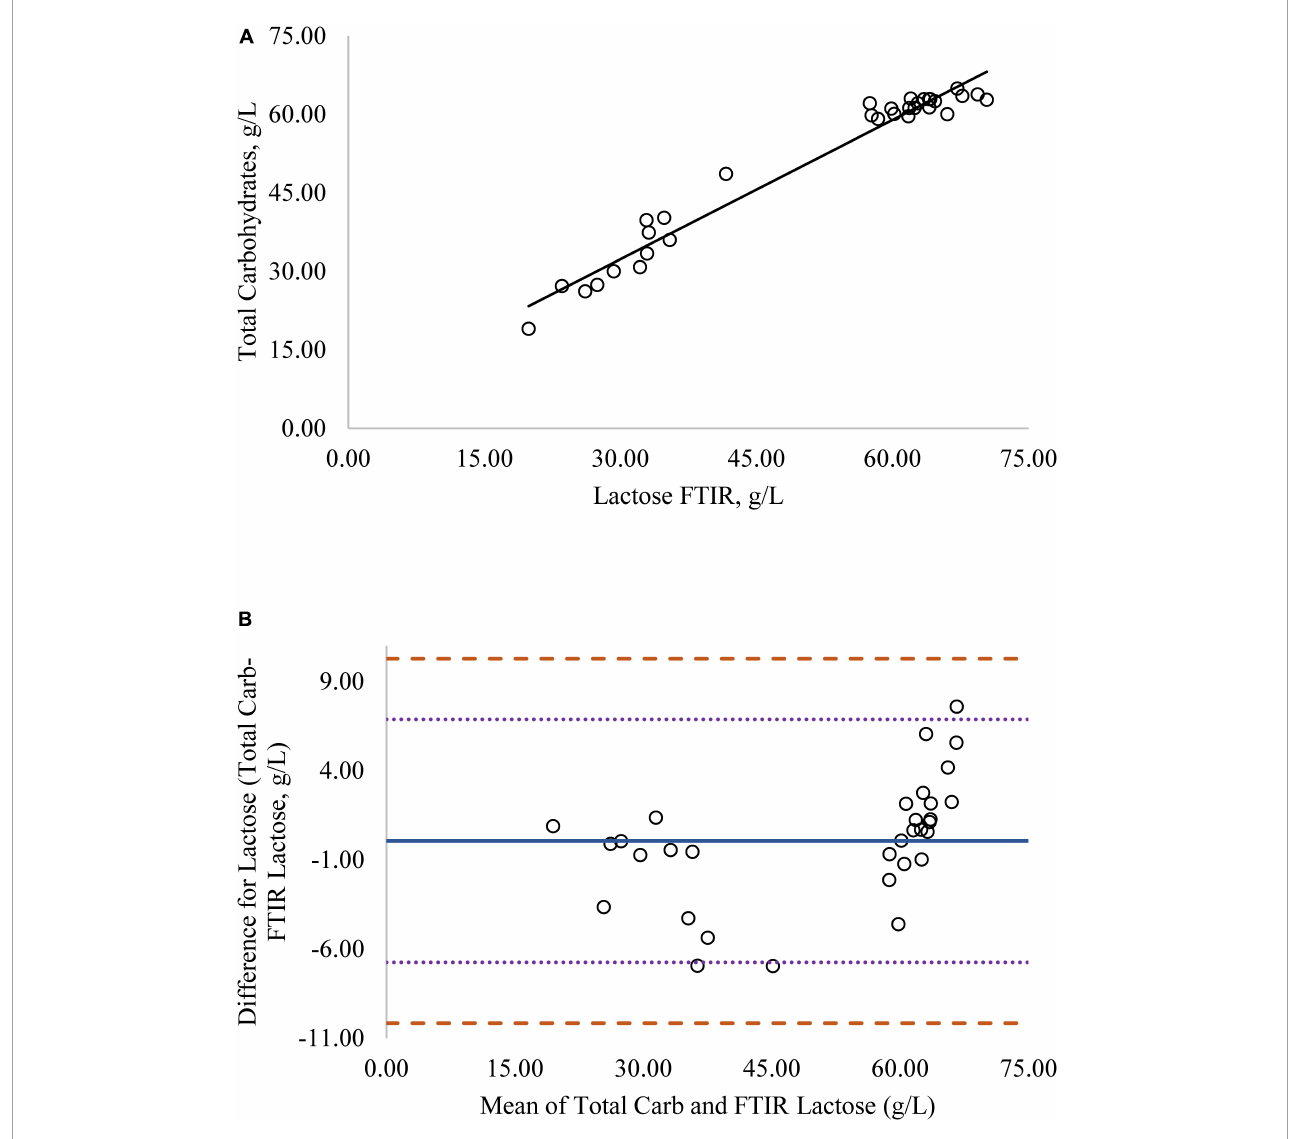
FIGURE4 (A) Mare milk lactose concentration measured by FTIR and total carbohydrate method. Correlation graph between the two methods for lactose, r 2 = 0.98, P < 0.0001. Regression model y = 0.920X + 4.512. (B) Mare milk lactose concentration measured by FTIR and total carbohydrate method. Bland-Altman plot showing the mean differences and limits of agreement. Bias line: solid line, two standard deviation (s.d.): dotted lines, three s.d.: dashed